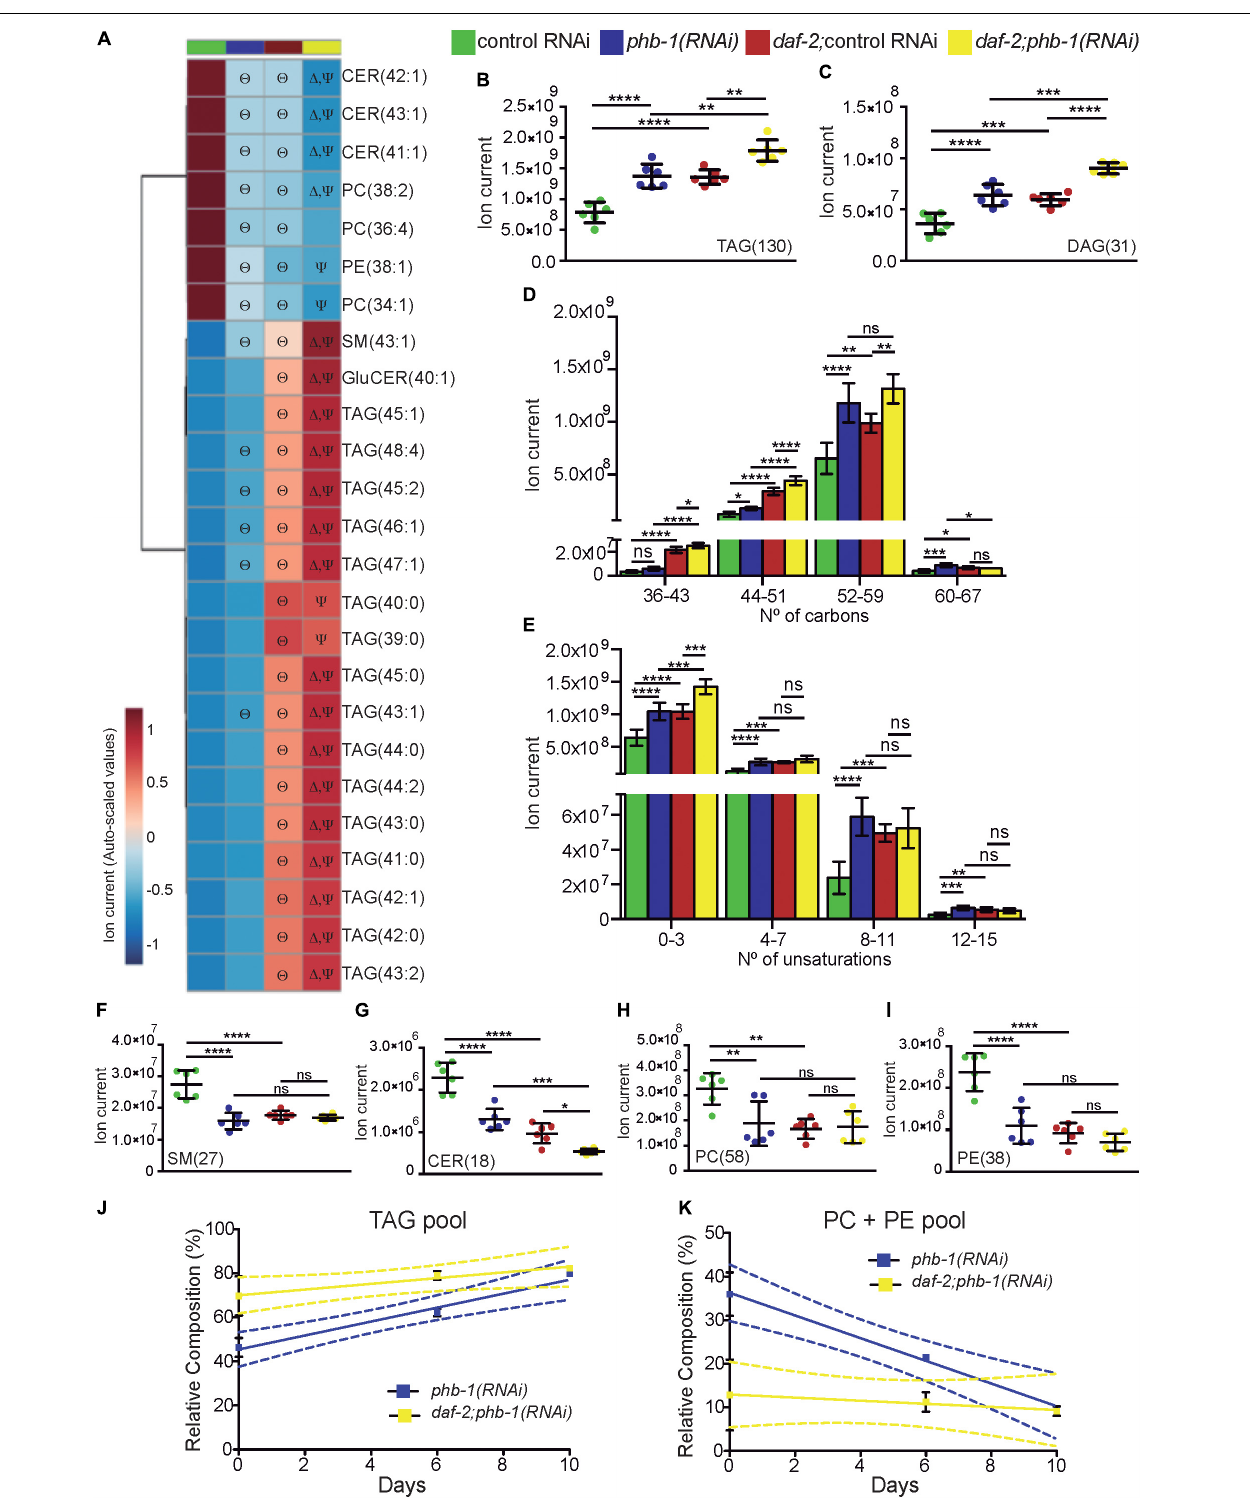
FIGURE 1 | Glycerolipid and glycerophospholipid pools are affected by PHB depletion in a genetic background dependent-manner. (A) Heat map displaying the top 25 lipid species, ranked based on the P-values coming from One-way ANOVA with post hoc Tukey multiple comparison test, responding to PHB deficiency and/or to daf-2(e1370) mutation. Statistical significance compared to control RNAi ( (cid:50) ), daf-2(e1370) mutation ( (cid:49) ) or phb-1(RNAi) ( (cid:57) ). (B,C) Quantification of the pools of